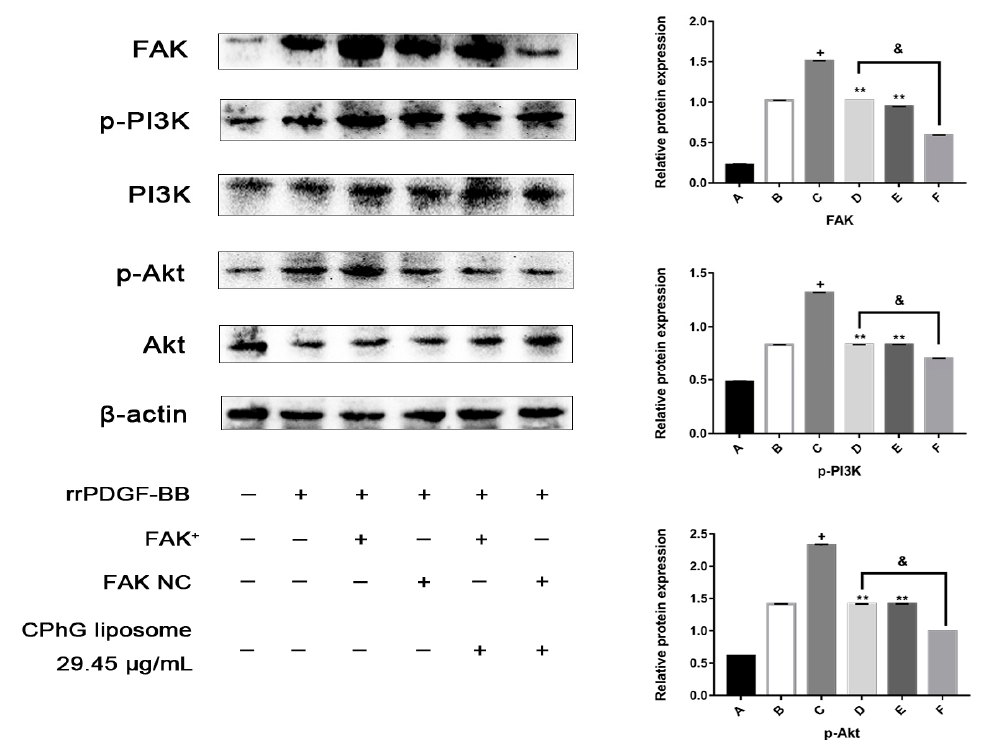
Figure 8. FAK, Phosphorylated and total PI3K and Akt in rrPDGF-BB-activated HSCs after overexpression of FAK. FAK, Phosphorylated and total PI3K and Akt protein were measured by western blotting with specific primary antibodies. ** p < 0.01, significantly different compared with the rrPDGF-BB stimulation + pEX-3-FAK group. + p < 0.05, significantly different compared with the rrPDGF-BB treated group. & p < 0.01, significantly different compared with the rrPDGF-BB stimulation + pEX-3-NC group. β -actin was used as an internal control.